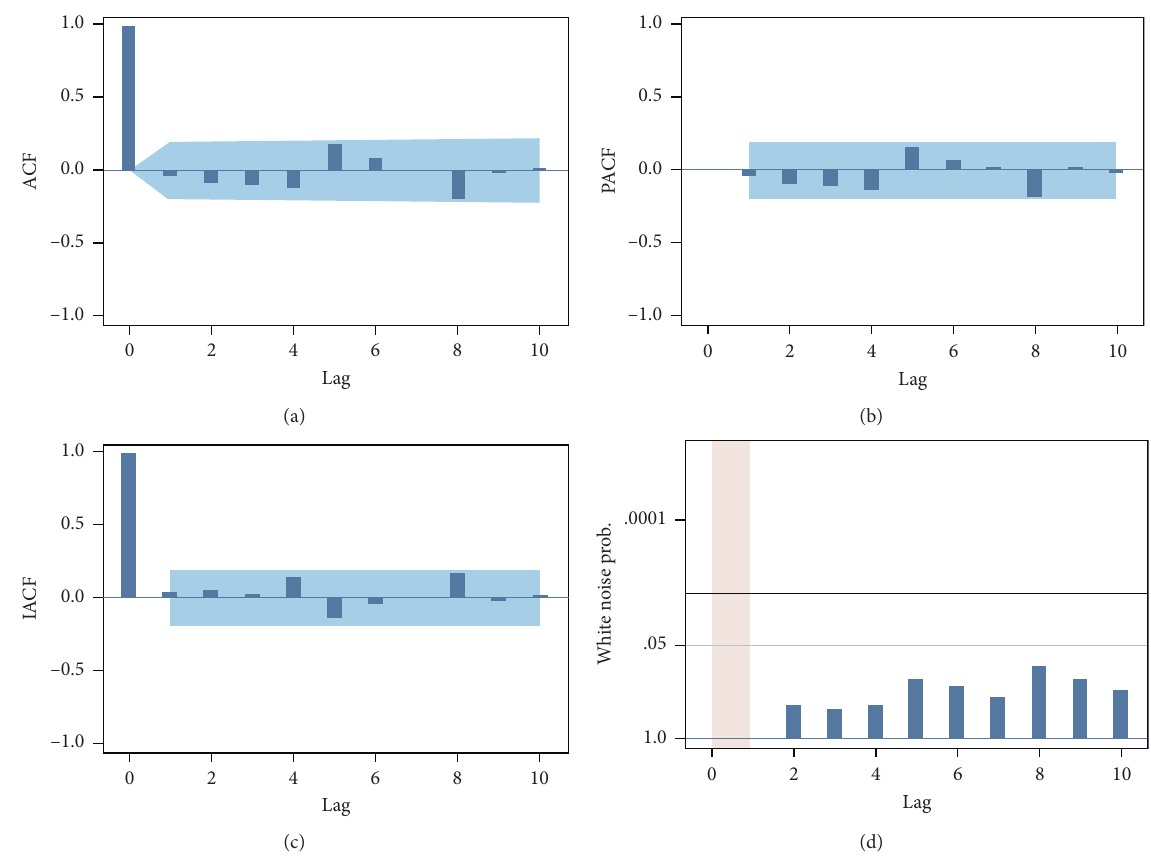
Figure 3: Autoregressive plots of residual error of LTF model. Table 1: Estimated results of green finance RDL model. Table 3: Estimation results of fintech RDL model. Parameter Estimate